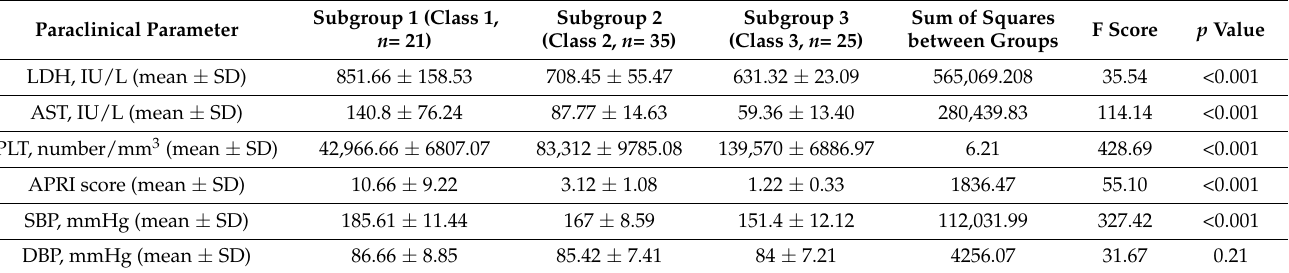
Table 3. Comparison of paraclinical characteristics for the patients included in the analyzed subgroups.